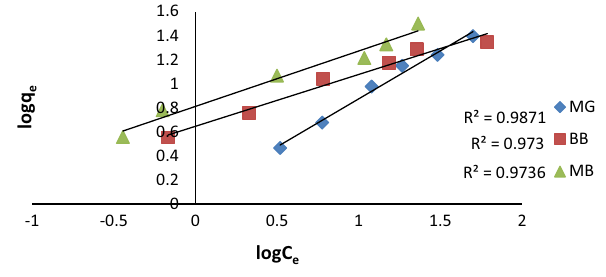
Fig. 7 Freundlich adsorption isotherm for Zn(II)